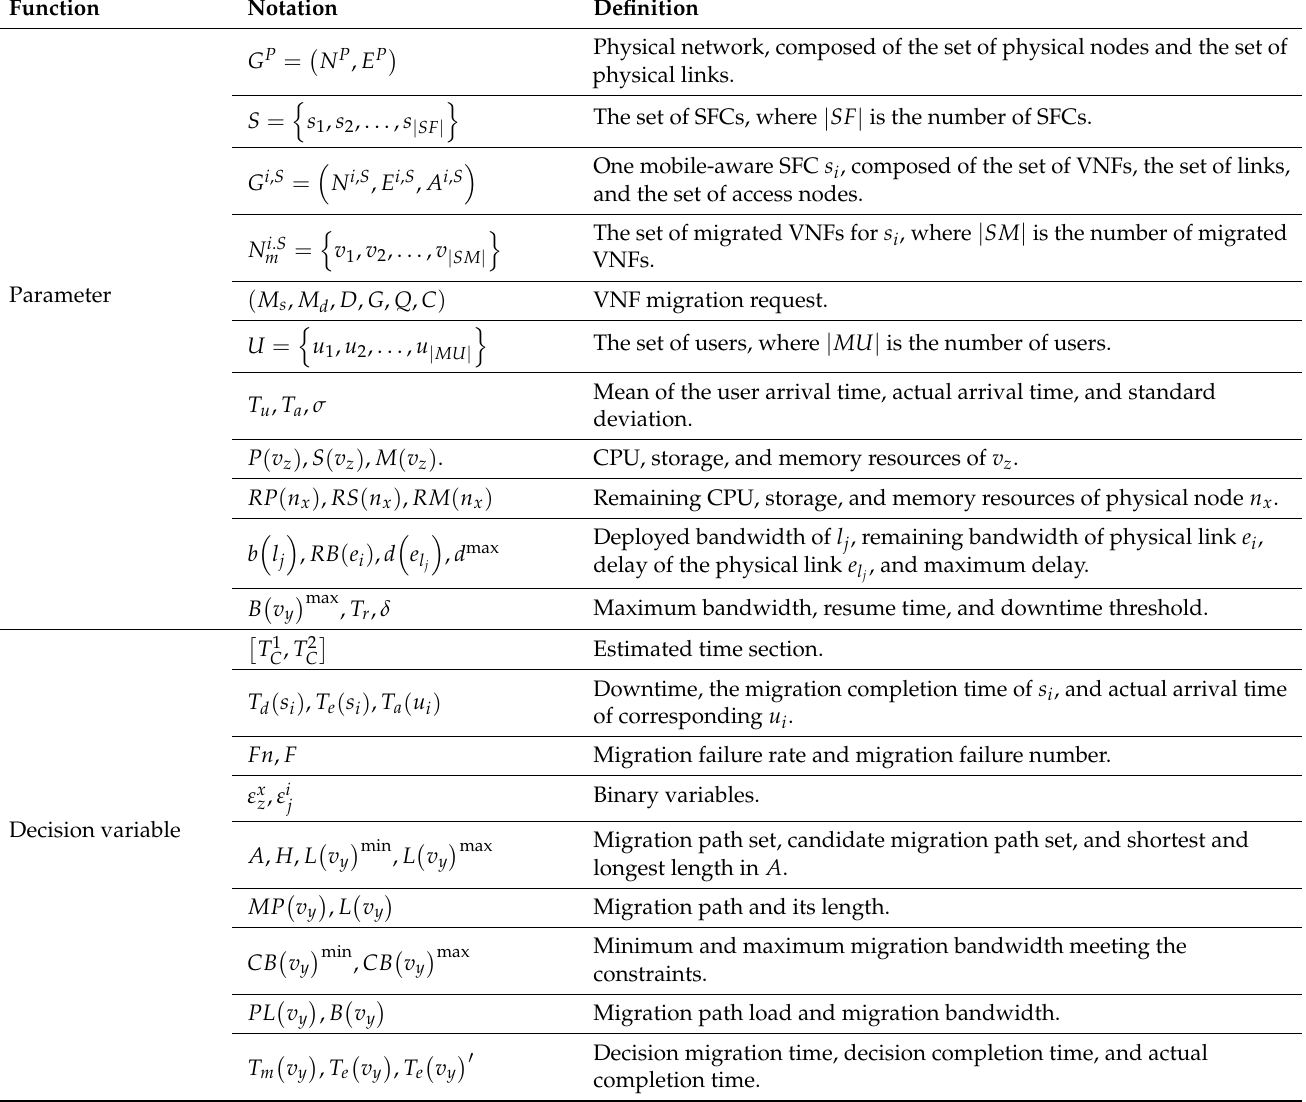
Table 1. Notations in the